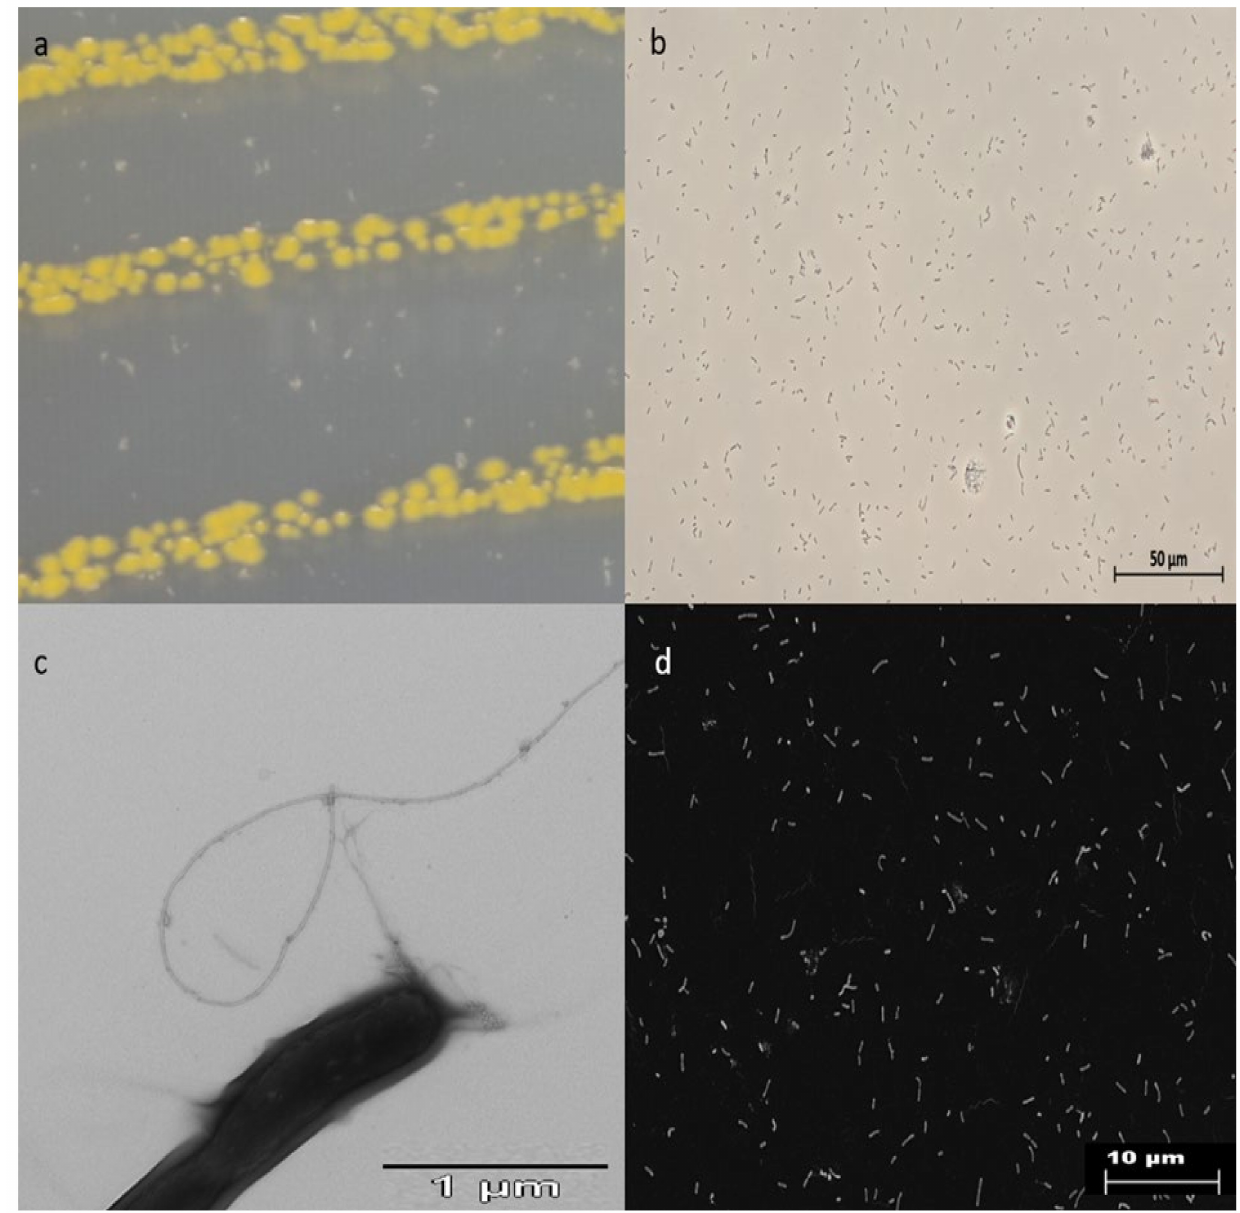
Figure 1. ( a ) Growth of strain NZ-12B T on marine agar after three days. ( b ) Phase contrast microscopy of strain NZ-12B T (bar 50 µ m). ( c ) Transmission electron microscope (TEM) image of negatively stained cells of NZ-12B T showing the presence of a single flagellum (1 µ m). ( d ) Scanning electron micrograph (SEM) of cells grown on marine agar (bar 10 µ m) depicting rod-shaped